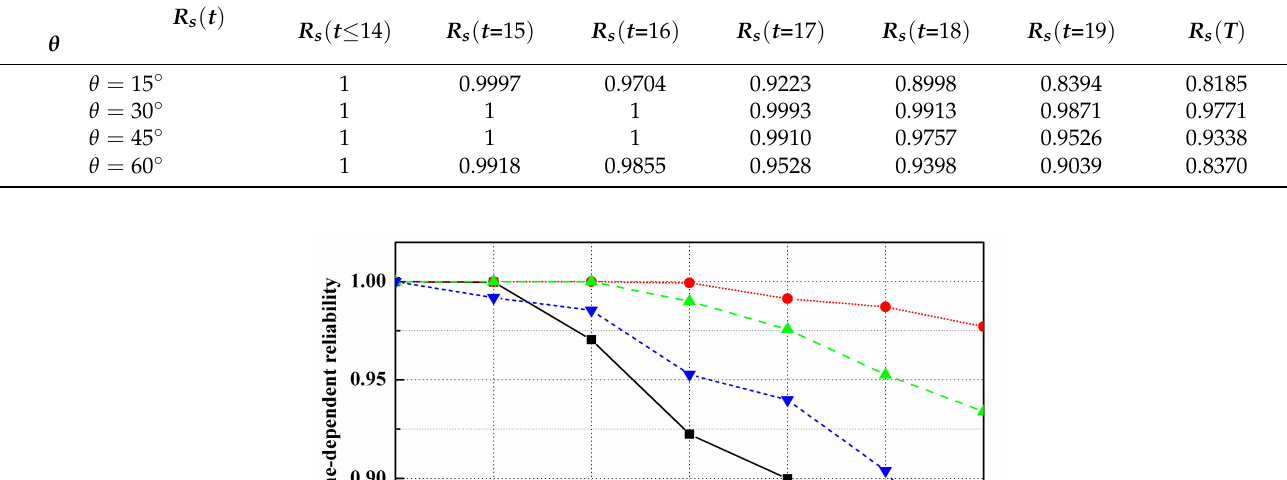
Table 4. Non-probabilistic time-dependent reliability results versus different values of ply angel θ .